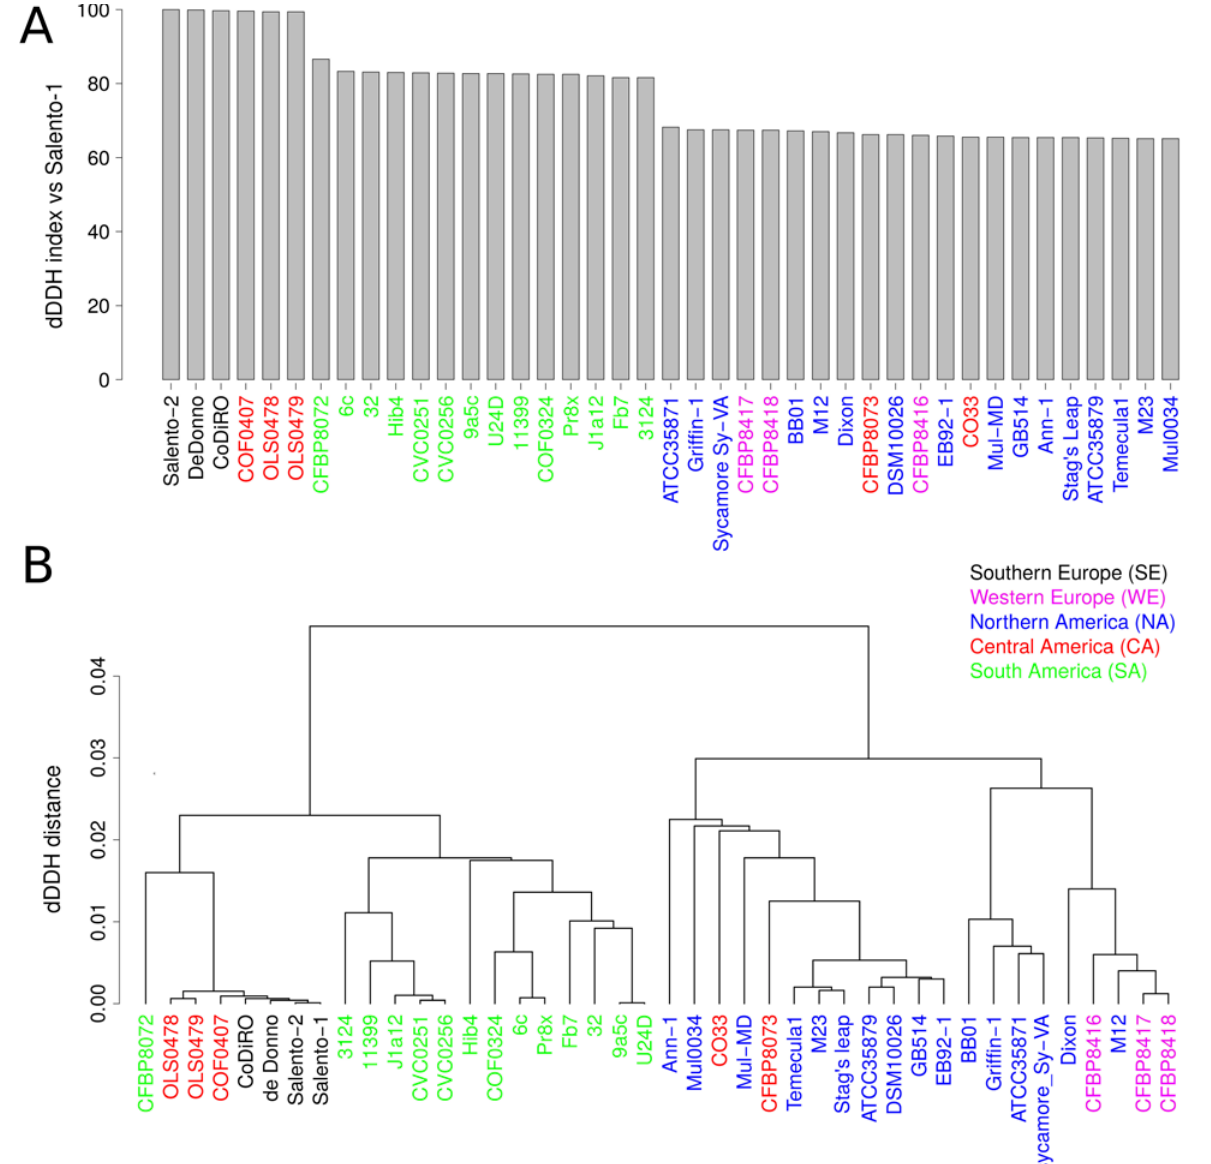
Figure 5. A, barplot showing, in decreasing order, the genomic (at all assembly status) dDDH indices of Xylella fastidiosa Salento-1 (NCPPB 4595; LMG 29352) versus all other strains included in this study. The Salento-1 genome sequence was used as the reference genome. B, complete hierarchical clustering based on dDDH-derived distance among strains. Isolates names are coloured according to the geographic region of origin of host plants from which they were isolated (see legend in the middle of the